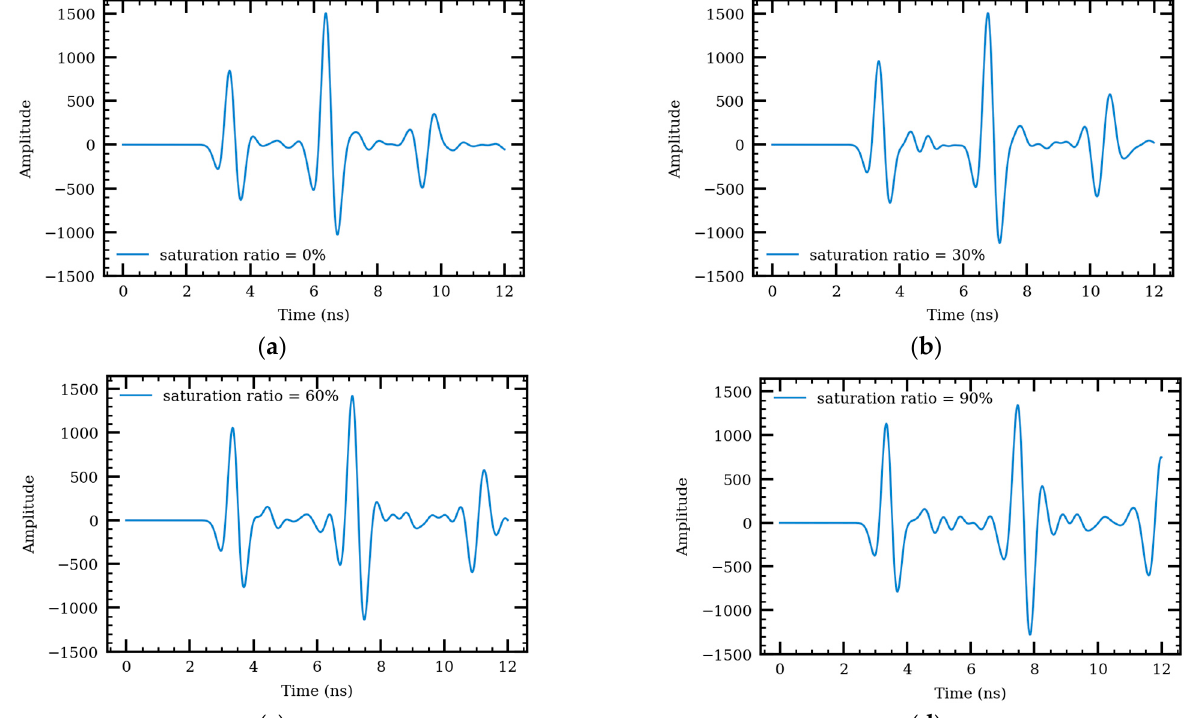
Figure 10. GPR signals on PEC-embedded pavement with different saturation ratios of ( a ) 0% ( b ) 30% ( c ) 60% ( d ) 90%.